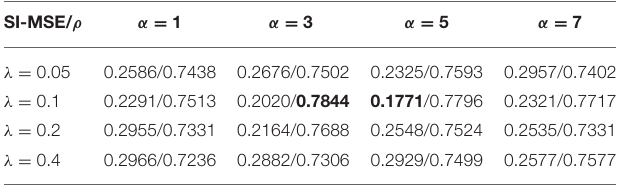
TABLE 4 | Comparison of our method for the synthesis of underwater images with different combinations. Baseline